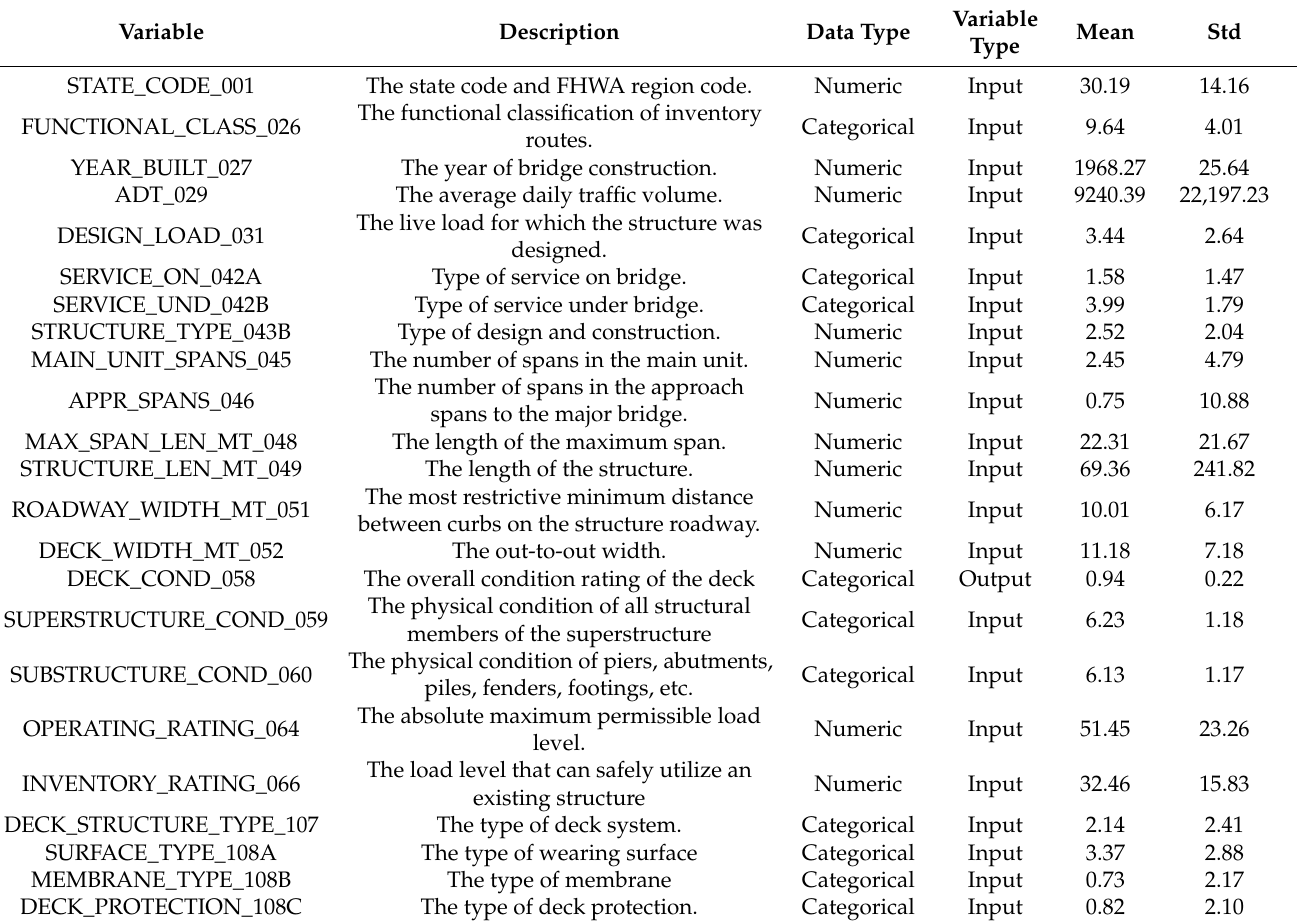
Table 2. Statistical analysis of characteristic